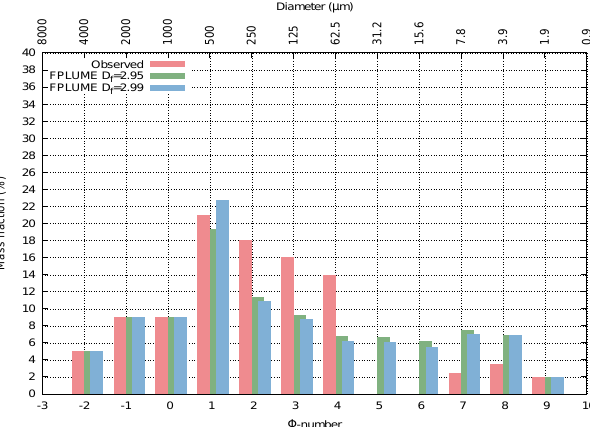
Figure 11. Grain size distribution predicted by the wet aggrega- tion model for Eyjafjallajökull 6 May phase for a column height of 6.5km (a.v.l.) for two different values of the fractal exponent D fo of 2.95 and 2.99. Observed data from Bonadonna et al.